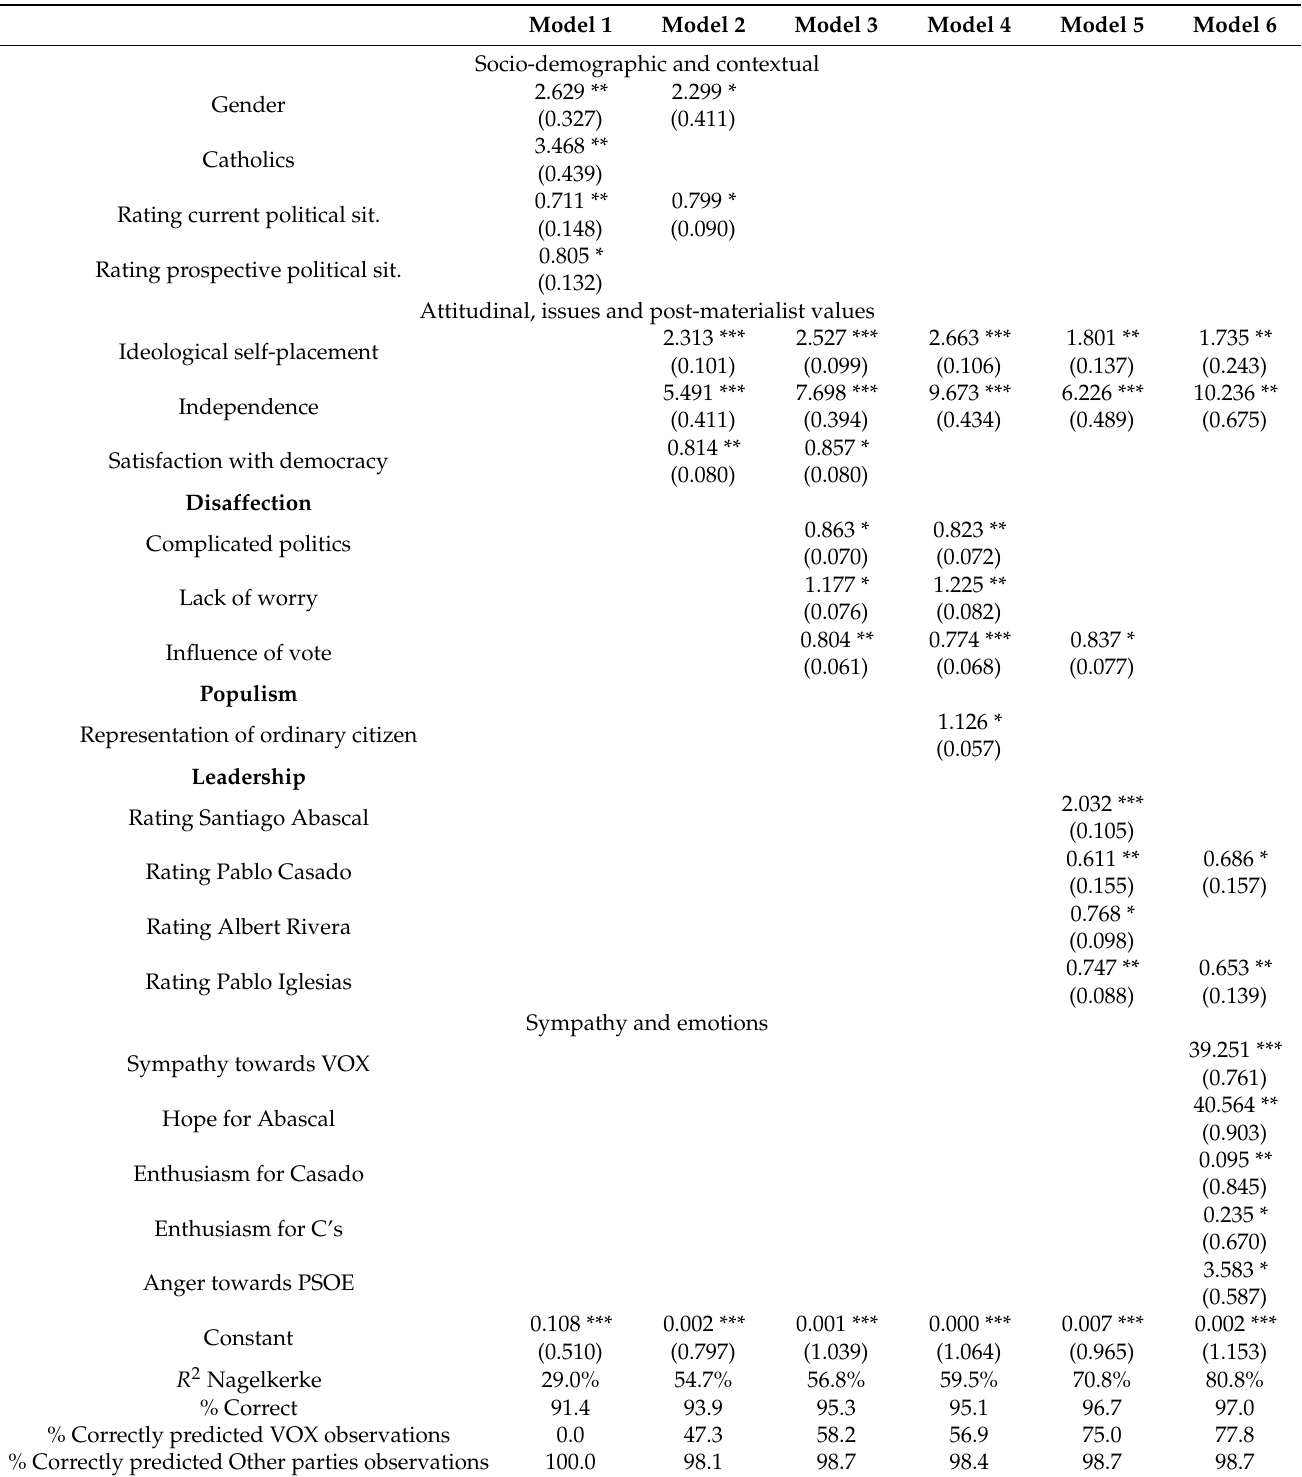
Table 3. Explanatory models of the vote for